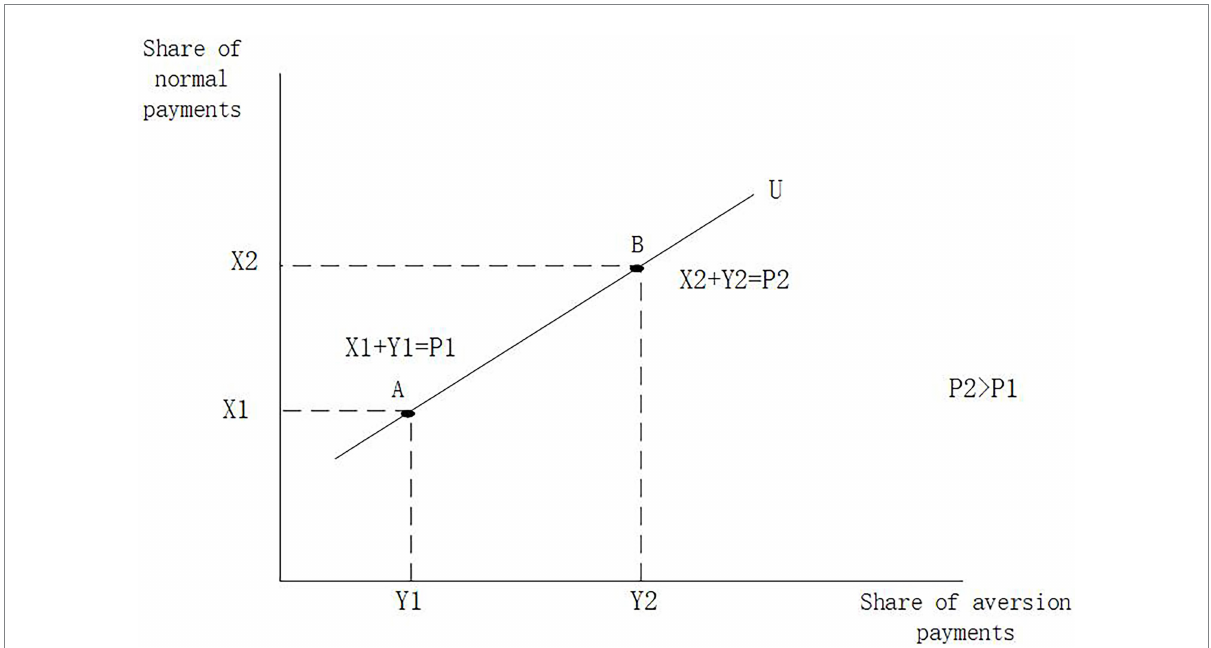
FIGURE 1 Note: In the above figure, P 1 at point A corresponds to the actual price paid by the tourist, but due to the incomplete match between the tourist product characteristics and the tourist preferences, only the amount paid for X 1 brings value return, while the amount paid for Y 1 brings a non- positive value return. If tourists’ preferences and tourism product characteristics match perfectly, at point A, the expenditure of P 1 should be fully compensated by the value return of X 2, but there is a deviation, and the price of P 2 must be paid to obtain the value return of X 2, which means more payments that cannot obtain the value return. If the consumer makes a choice based on utility, A and B are equivalent, so we convert the consumer’s utility at point A to the utility at point B